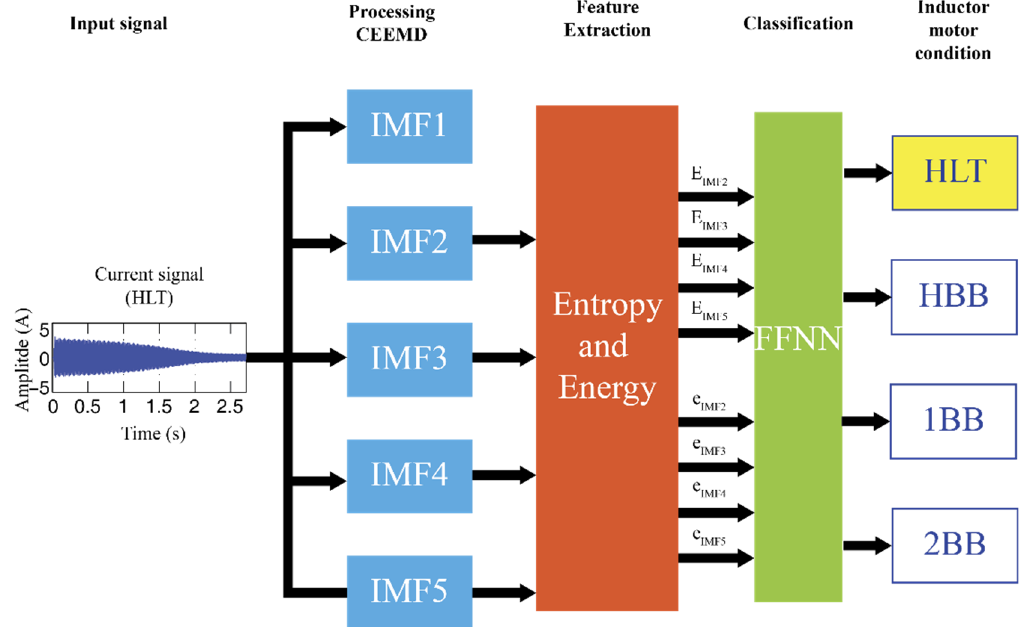
Figure 2. Proposed flowchart for signal processing, showing a healthy induction motor condition. IMF—intrinsic mode function; HLT—healthy condition; HBB—half broken bar